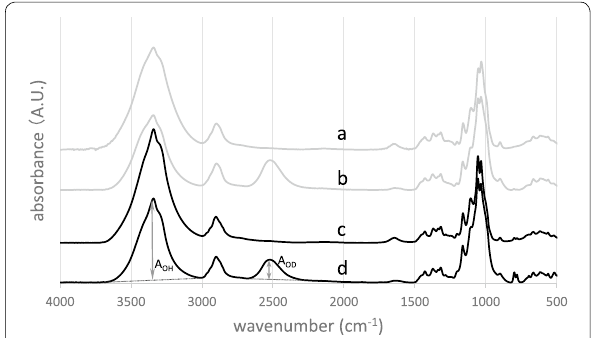
Fig. 6 Infra-red spectra of bagasse cellulose a before hydrolysis and before deuteration, b before hydrolysis and after deuteration, c after hydrolysis for 196 h and before deuteration, and d after hydrolysis for 196 h and after